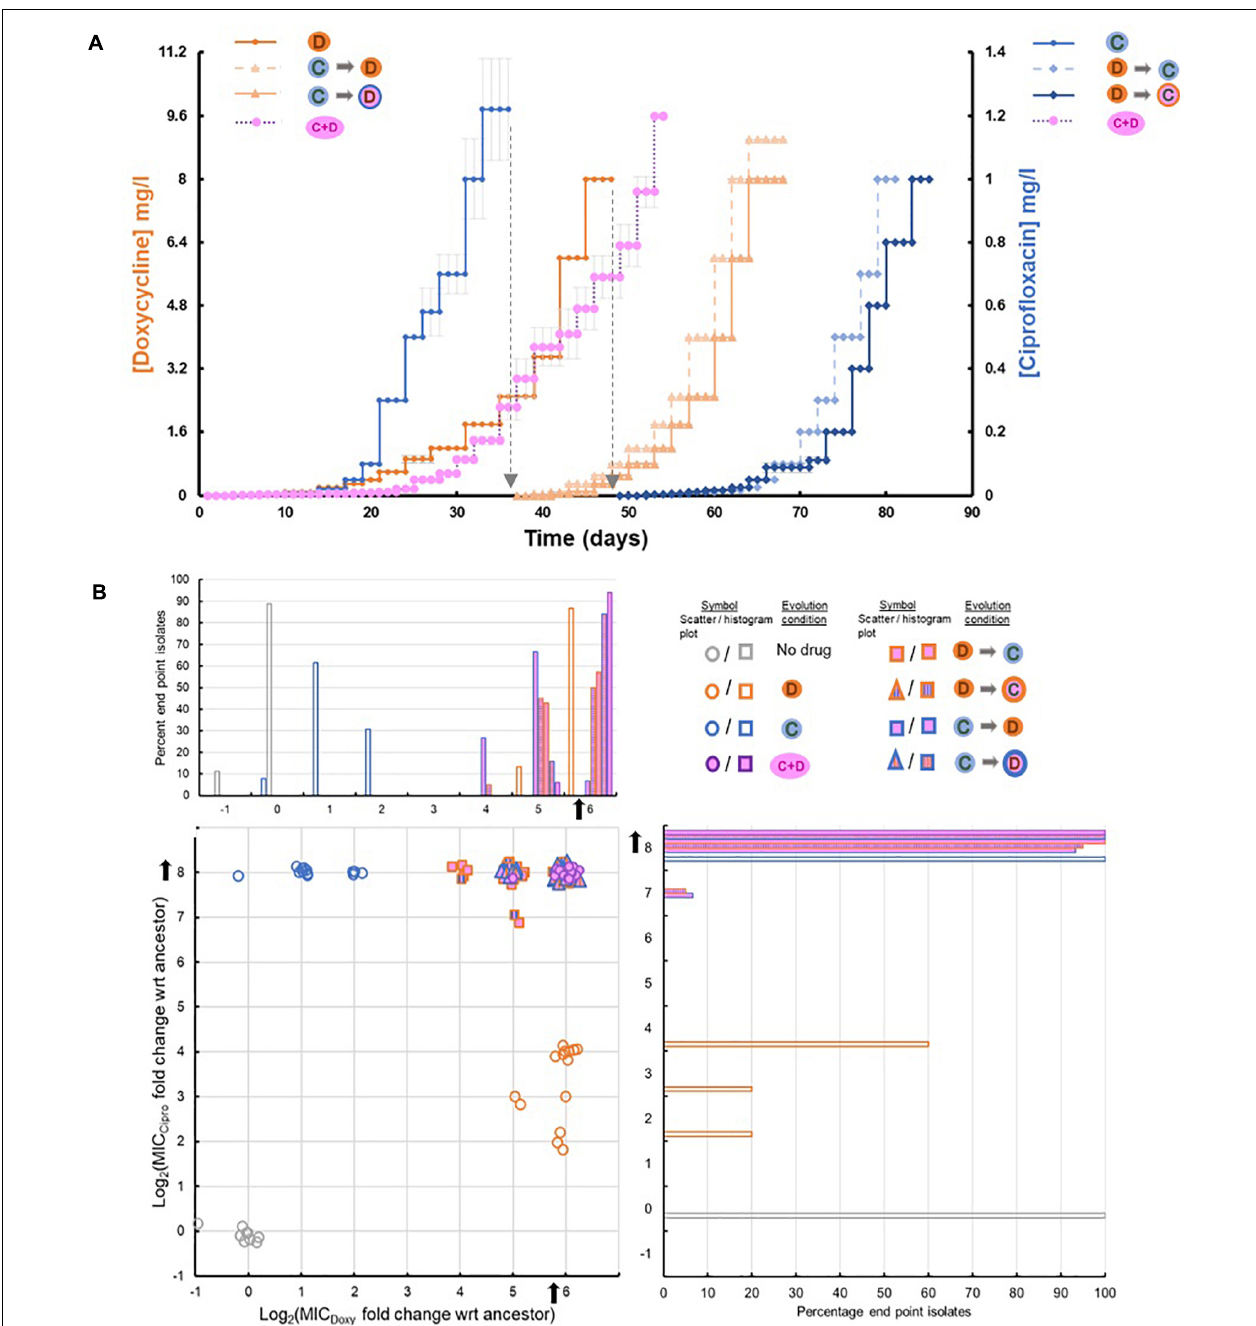
FIGURE 2 | (A) Timeline of evolution to different selection environments. The graph shows the step-wise gradient of sub-inhibitory drug concentrations used during evolution of LVS. Text at the top of each curve indicates the selection condition used. The primary Y-axis (left) represents the DOX concentration in mg/l and the secondary Y-axis (right) represents the CIP concentration in mg/l. Symbols for the various selection conditions used are from Figure 1 . The same symbols are shown alongside each of the Y-axes to indicate the axis (or the drug) relevant to each curve. For the yellow curve, which represents timeline of evolution to combinatorial selection, DOX concentrations can be seen on the left and CIP concentrations on the right. The black dotted line indicates the use of the relevant mono-evolved population for sequential selection to the second drug. (B) Distribution of evolved end point isolates based on their Minimum Inhibitory Concentrations (MICs) of DOX and CIP. The X and Y axes on the scatter plot represent the log 2 fold change in MIC of DOX and CIP compared to wild type LVS strain. Noise has been added to each data point to create separation. The mono-evolved end point isolates cluster in independent regions indicating resistance to the selection used, while all the sequential and combinatorial evolved end point isolates cluster in the top right corner of the graph which indicates high levels of resistance to both drugs. The histogram above the scatter plot shares its X-axis with the scatter plot and the one on the right shares its Y-axis with the scatter plot. Each histogram shows the percentage of end point isolates from each selection regime falling into the respective log 2 MIC fold change category.